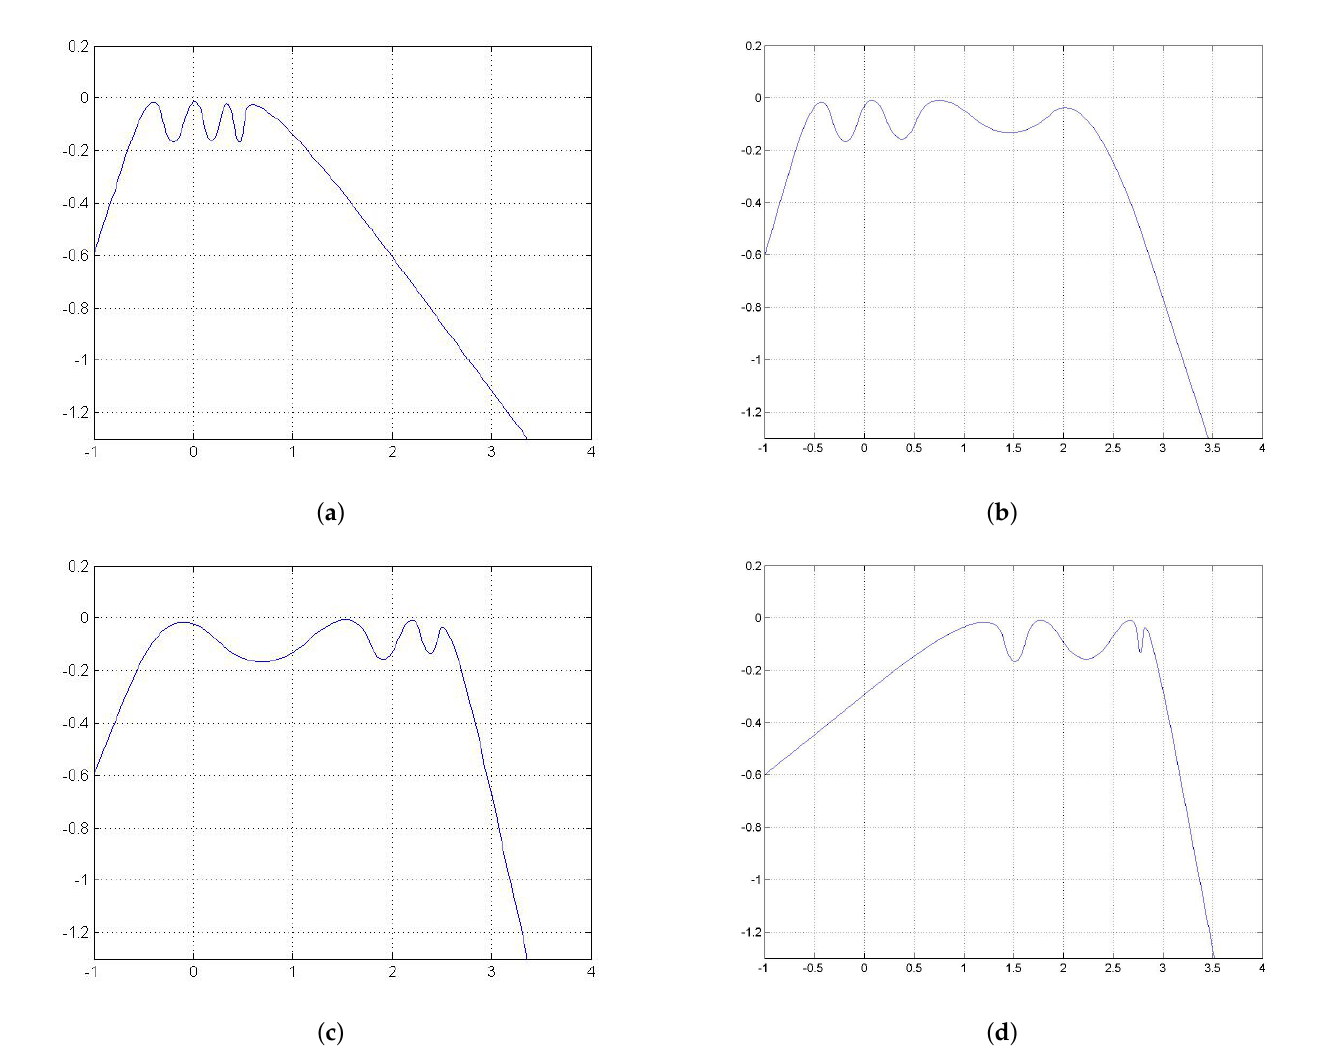
Figure 2. The plot of c ( x , ξ , µ ∗ ) versus x on nested PSO algorithm for two parameter logistic regression model. Vertical coordinate represents the value of c ( x , ξ , µ ∗ ) , and horizontal coordinate represents the value of x. ( a ) Logistic regression model with optimistic coefficient criterion, α = 0.7; ( b ) Logistic regression model with optimistic coefficient criterion, α = 0.5; ( c ) Logistic regression model with optimistic coefficient criterion, α = 0.3; ( d ) Logistic regression model with minimax regret